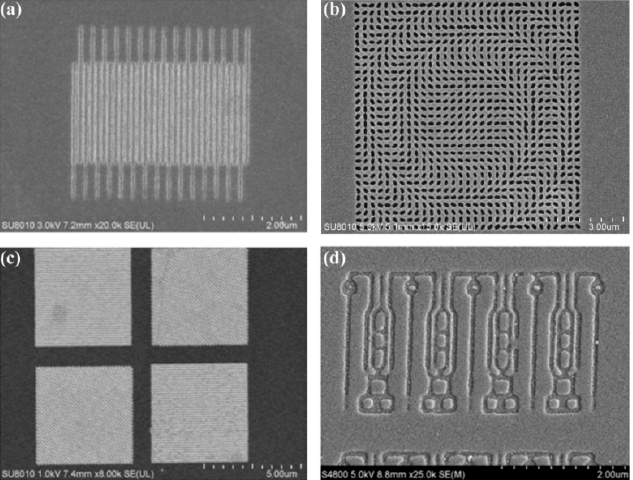
Figure 35. SEM pictures of plasmonic lithography for nanostructure employed in ( a ) integrated circuit, ( b ) nanofocusing optical lens based on metasurface, ( c ) surface plasmon polaritons couplers, ( d ) data recording circuit. Feature size of patterns ranges from 30 to 60 nm. Reproduced from [117], Copyright © 2015,